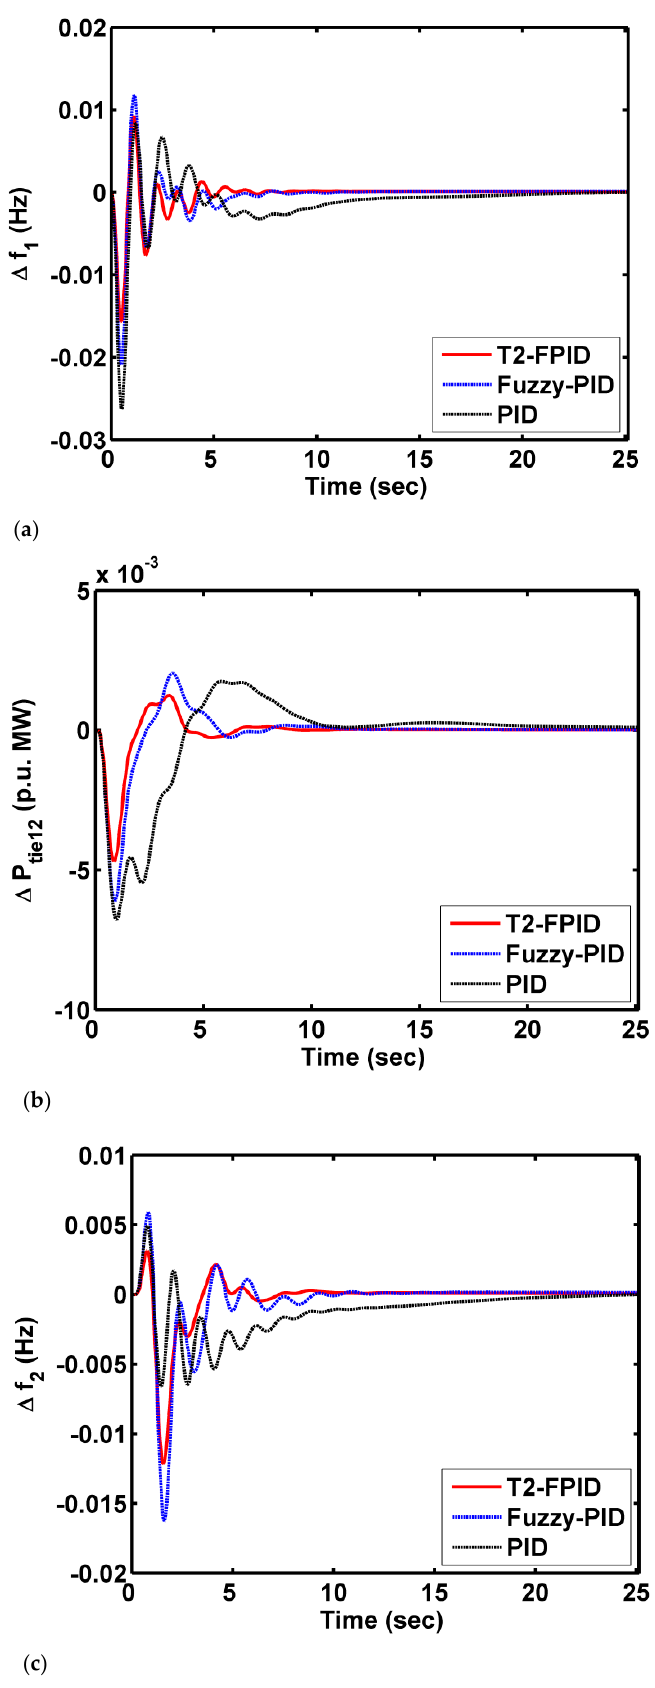
∆ f ∆ P tie 12 and ( c ) 1 ( b )